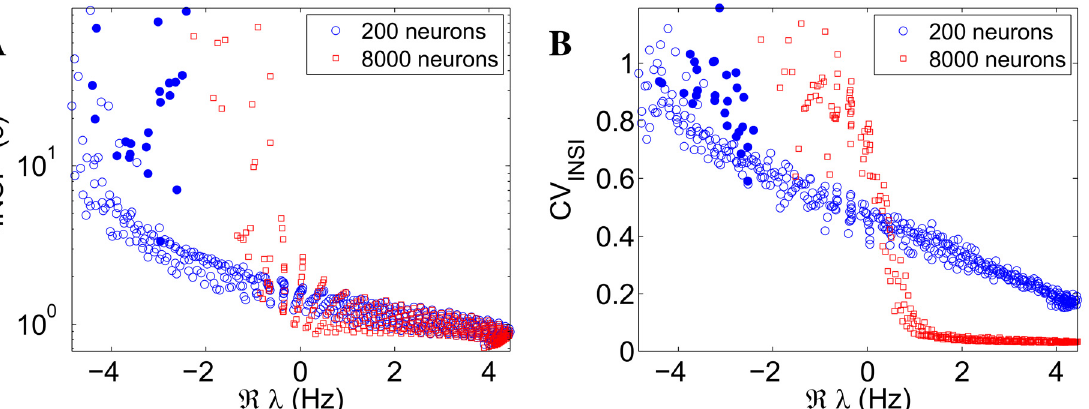
Fig 3. Stability analysis of the linearized dynamics captures most of the variability in the inter-network-spike interval (INSI) statistics. h INSI i (panel A) and CV INSI (panel B) vs the real part < λ of the dominant eigenvalue of the Jacobian of the linearized dynamics, for two networks that are pointwise identical in the excitation-inhibition plane, except for their size (circles: 200 neurons, as in Fig 2; squares: 8000 neurons). The data points almost collapse on 1-D curves when plotted as functions of < λ , leading effectively to a “ quasi one-dimensional ” representation of the INSI statistics in the (w exc , w inh )-plane. The region in which the INSIs are neither regular (CV INSI * 0) nor completely random (CV INSI ’ 1), as typically observed in experimental data, shrinks for larger networks. The filled circles mark a null imaginary part I λ